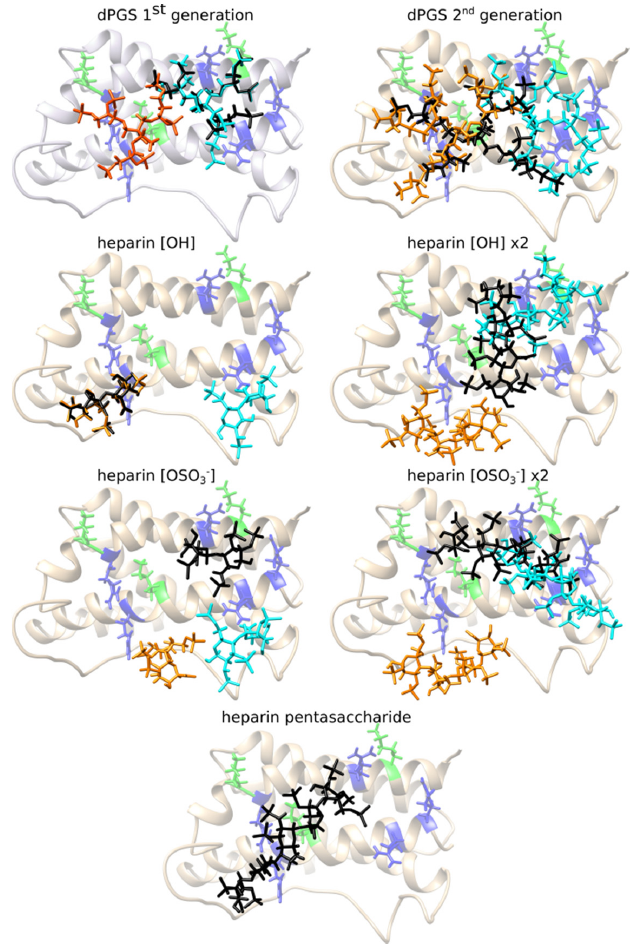
Figure 2. The most favorable binding positions for different ligands and binding sites of IL-6. Lysine form the docking sites is colored green, arginine is colored blue. Orange structure represents the corresponding pose obtained in the RKRK docking box; cyan pose obtained in the KRRR docking box, and black is the pose obtained in the docking box (iii) RKRK&KRRR which surrounds both binding sites.